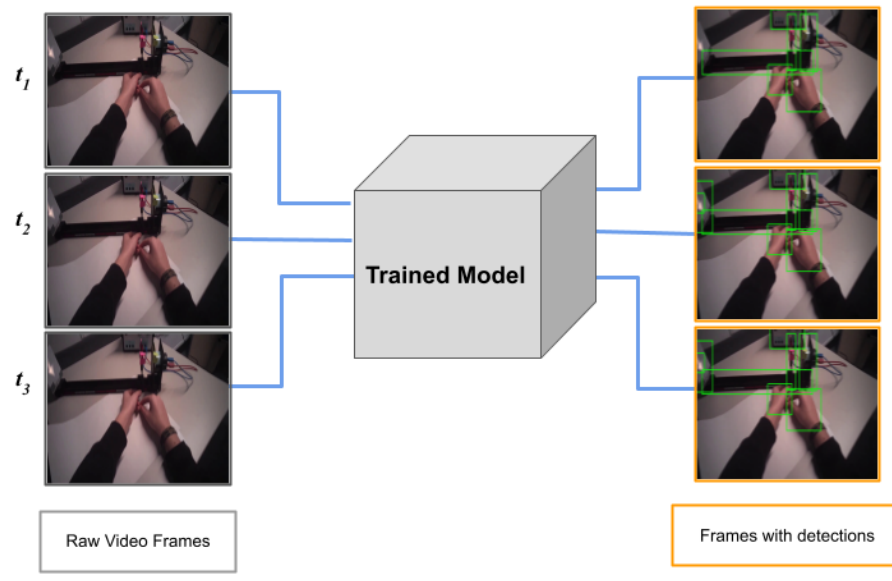
Figure 1. Each frame of the video is passed through the trained model (for more details, see Section 3.5), resulting in multiple predictions (bounding boxes) at each timestamp. The figure above shows object detection for three consecutive frames of a